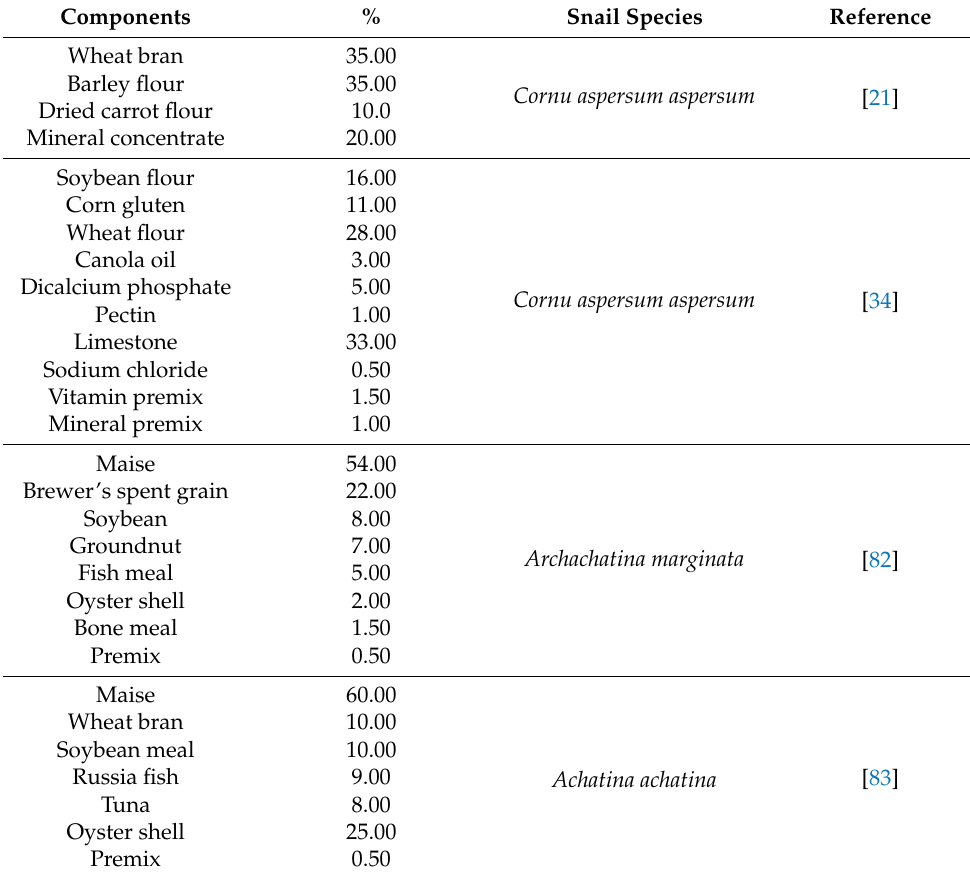
Table 7. Examples of feed mixtures used in feeding edible landedible snails. Components Snail